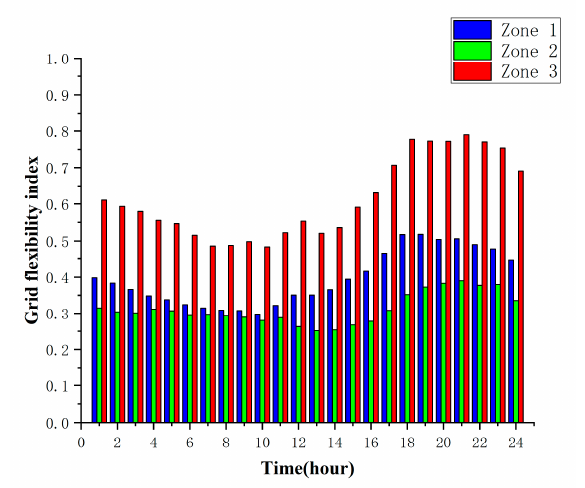
Figure 11. Grid flexibility index of each